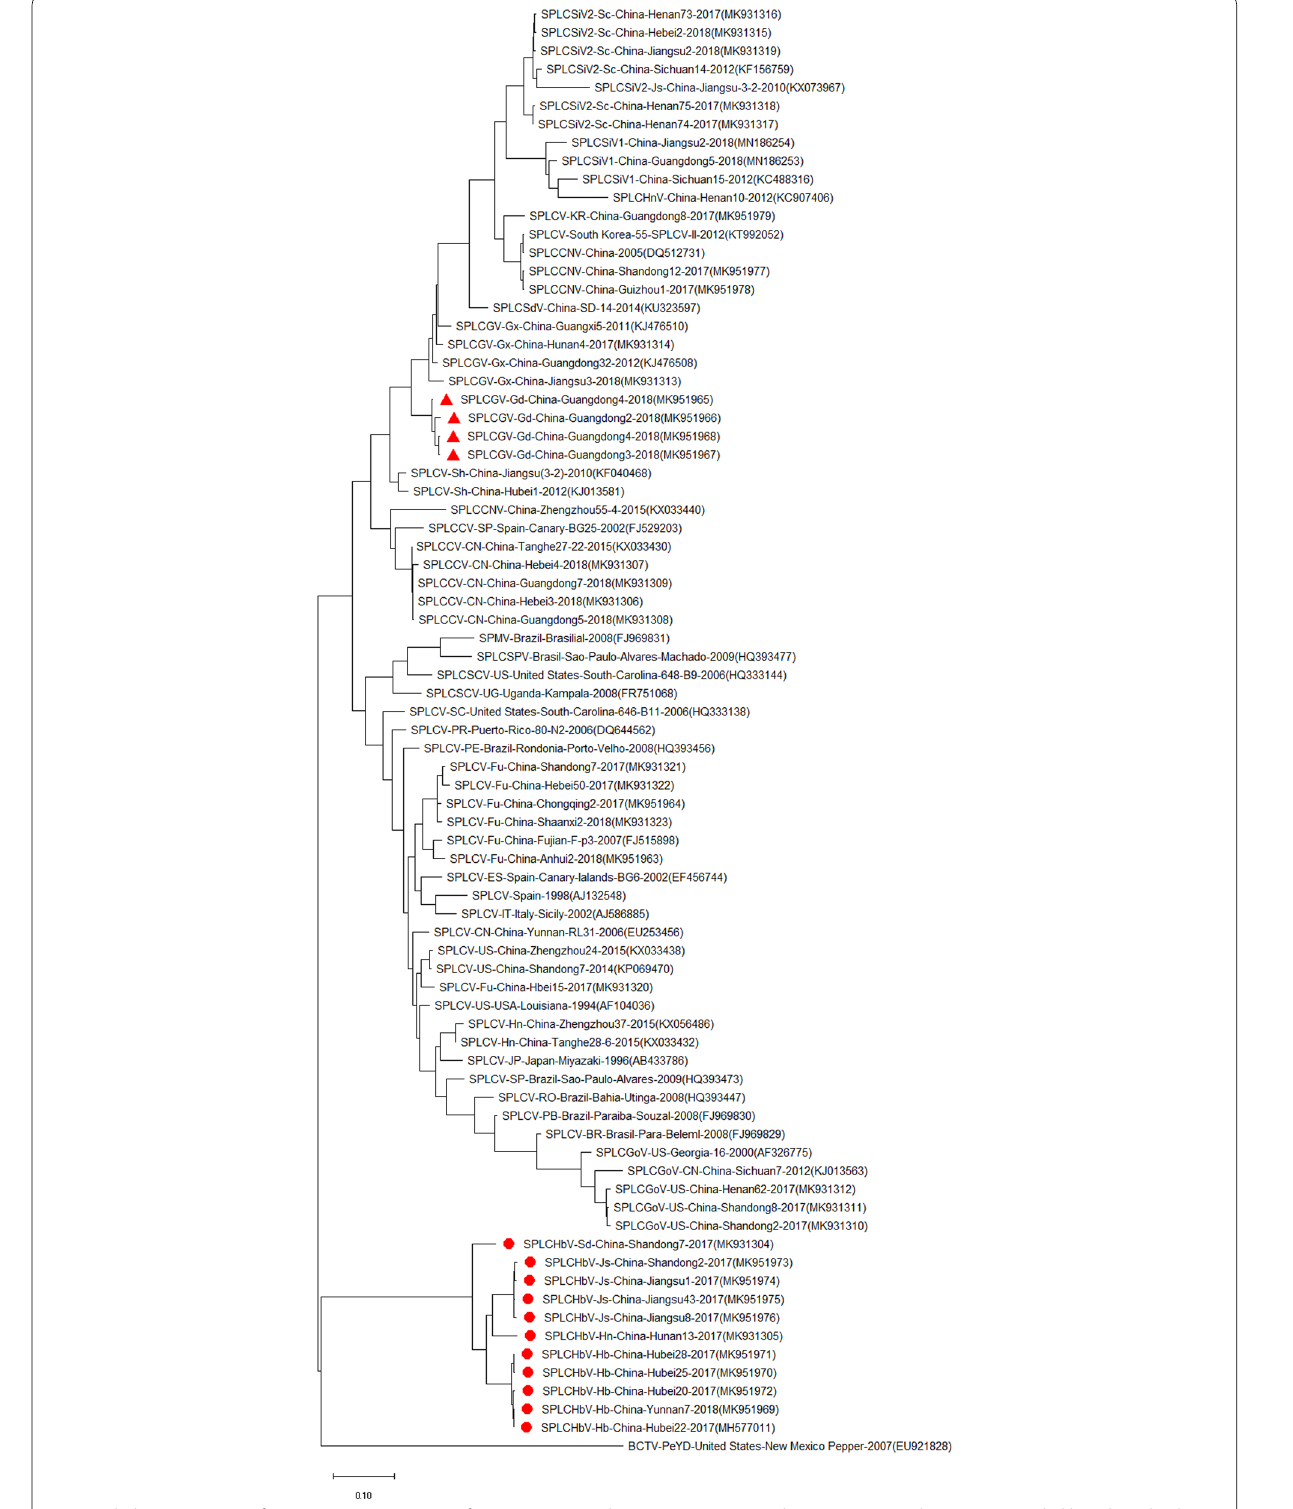
Fig. 2 Phylogenetic tree of 79 genome sequences of sweepoviruses. The tree was generated using MEGA X (the Maximum Likelihood method, General Time Reversible model and 1000 bootstrap replicates). New species and new strains are marked with dot and triangle, respectively. BCTV-PeYD (EU921828) was used as an